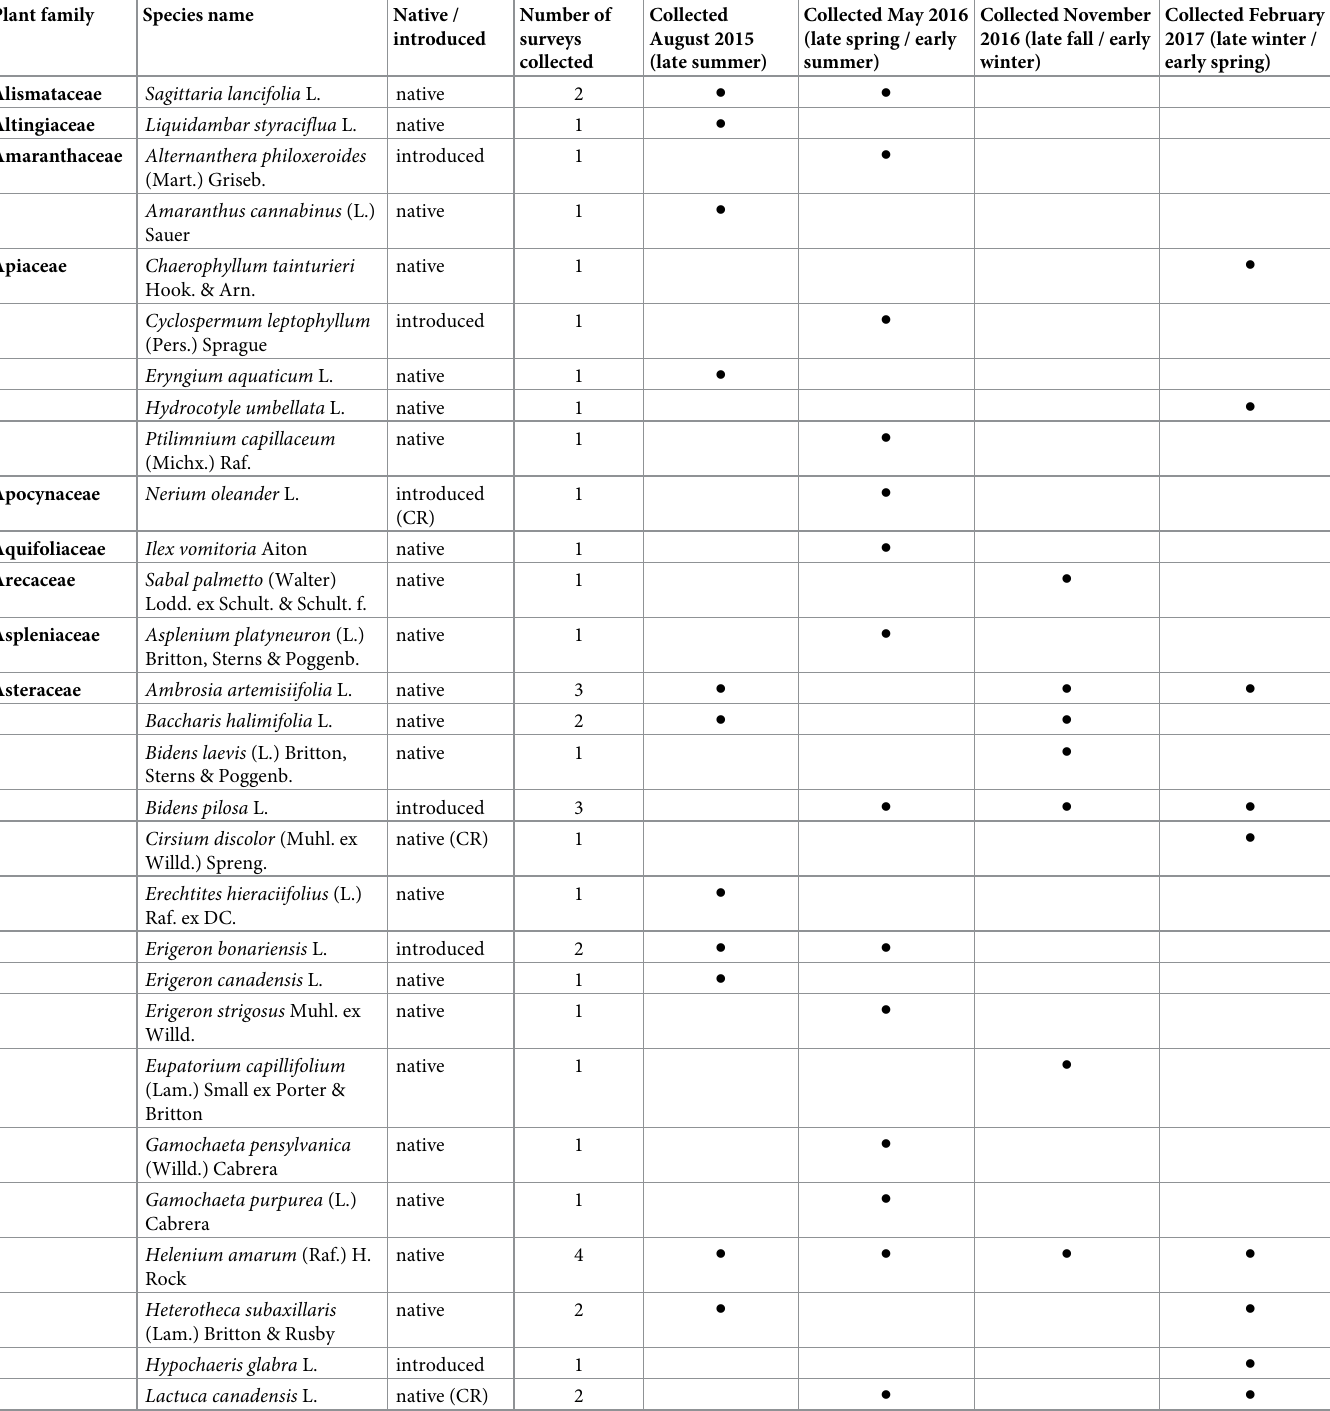
Table 2. List of species comprising the Industrialized Flora at the Port of Savannah, Georgia, USA. Within the Native / introduced column, (SR) indicates a state record for a species that has not previously been reported as occurring within Georgia, and (CR) indicates a county record for a species that has not previously been reported in Chatham County, Georgia, according to the Biota of North America Program (BONAP) [40]. All species are represented by vouchers stored at Arkansas State University Herbarium (STAR) and Columbus State University Herbarium